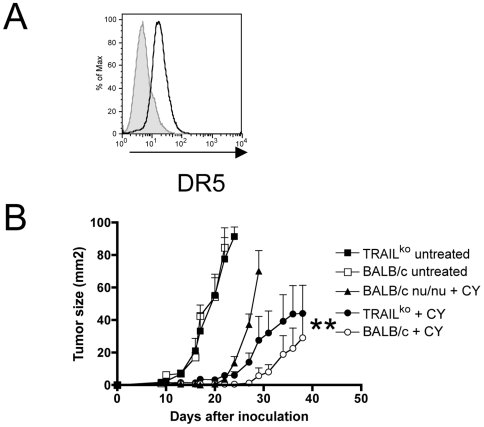
Role of TRAIL-mediated tumor cell apoptosis.(A) DR5 expression on AB1-HA tumor cells in vitro. (B) Tumor growth curves in CY-treated and untreated TRAIL-deficient mice, compared with immunocompetent mice and nude mice. Data shown are mean±SEM (n = 10) from two combined experiments. Tumor cells were inoculated at day 0 and treated with CY at day 10. ** P<0.005 when CY in BALB/c is compared with CY in TRAIL-deficient mice.